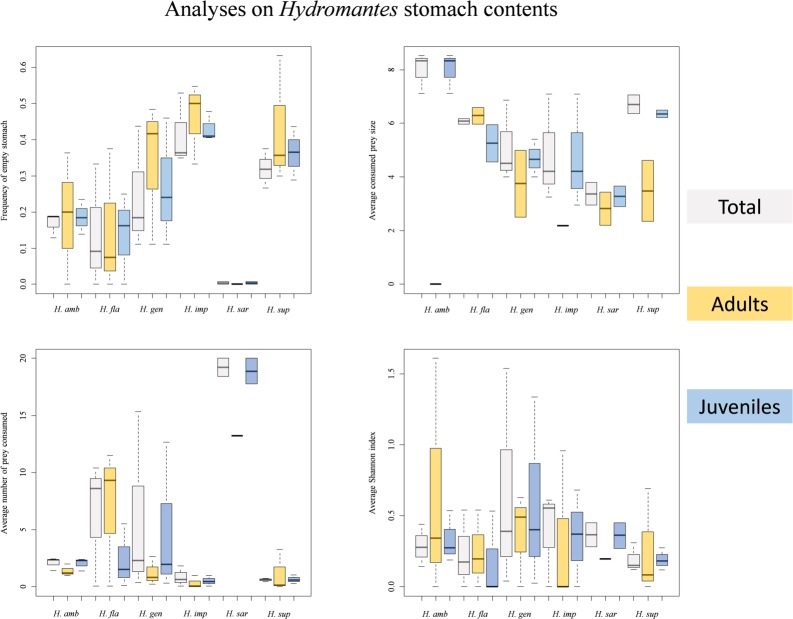
Boxplots showing variation of salamanders’ stomach contents among species and age classes.A) Average frequency of empty stomach; B) average consumed prey size (mm); C) average number of consumed prey; D) average diversity (Shannon index). For each species, averages (±SE) are calculated considering the populations from which salamanders were sampled during each season. Grey = all individuals; orange = adults; blue = juveniles.